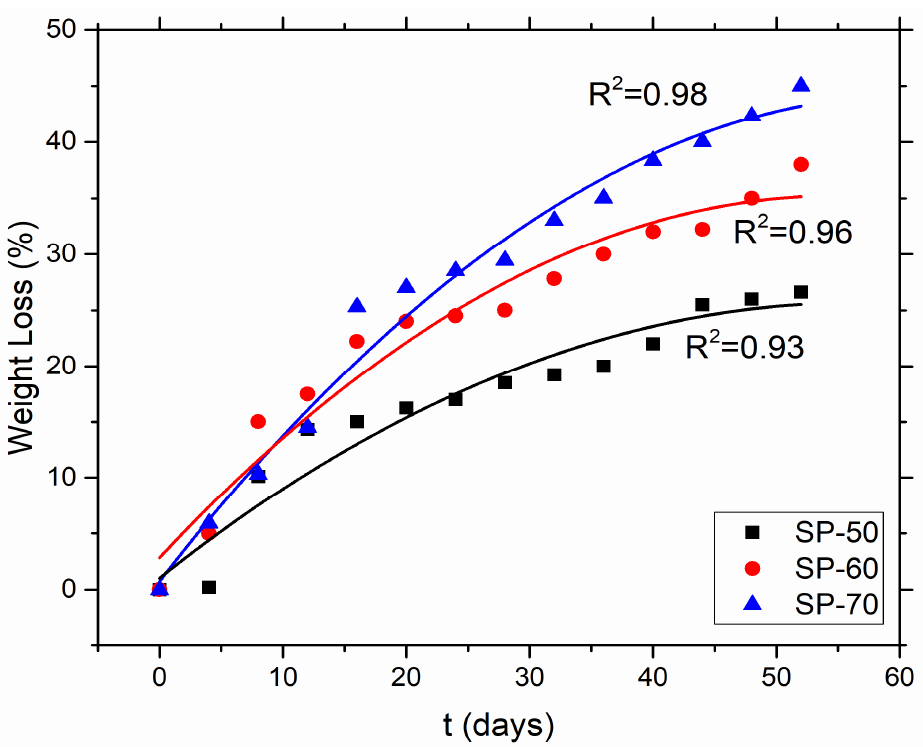
Figure 9. Weight loss of copolymers vs. soil burial time (days).